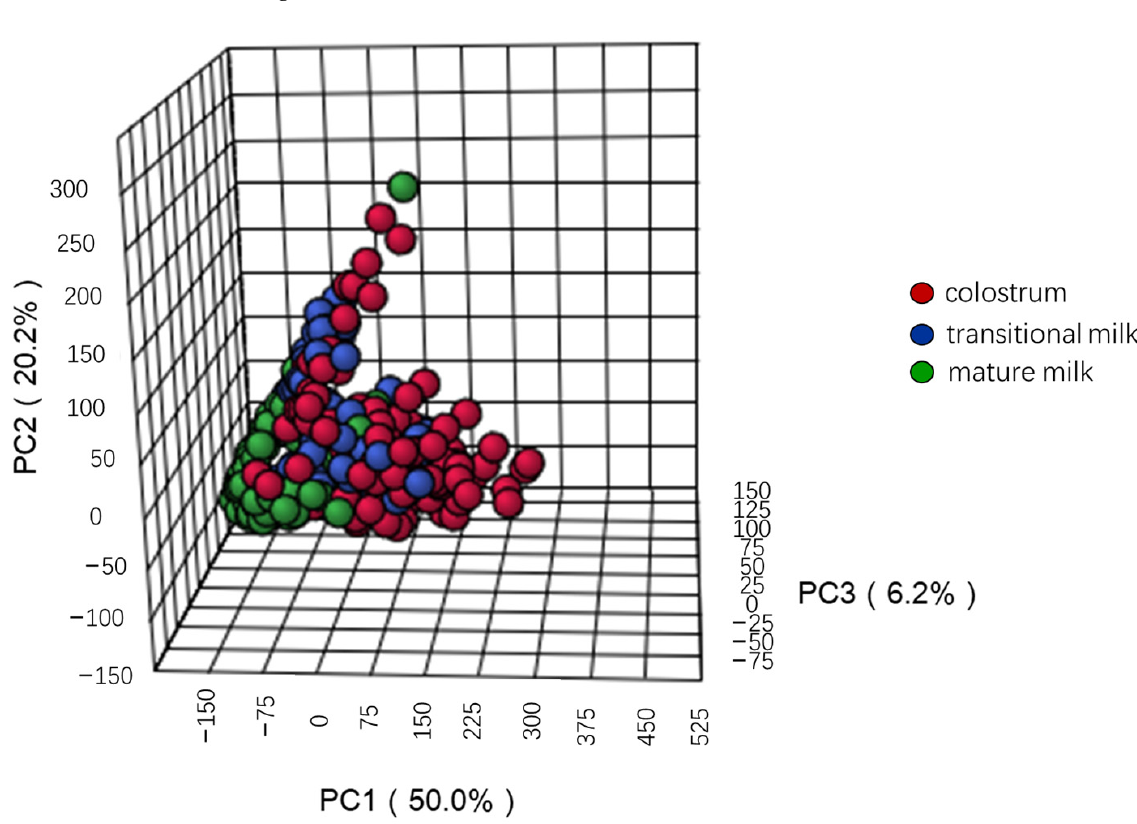
Figure 1. PCA of oligosaccharides at di ff erent lactation stages.